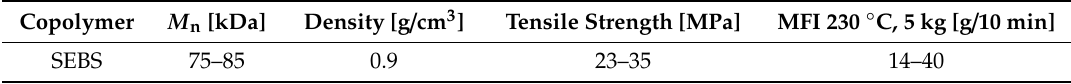
Table 1. Selected physicochemical properties of SEBS